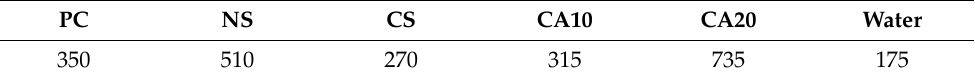
Table 1. Mix proportion of tested normal concrete mixes to assess pozzolanicity (kg/m 3 ) .